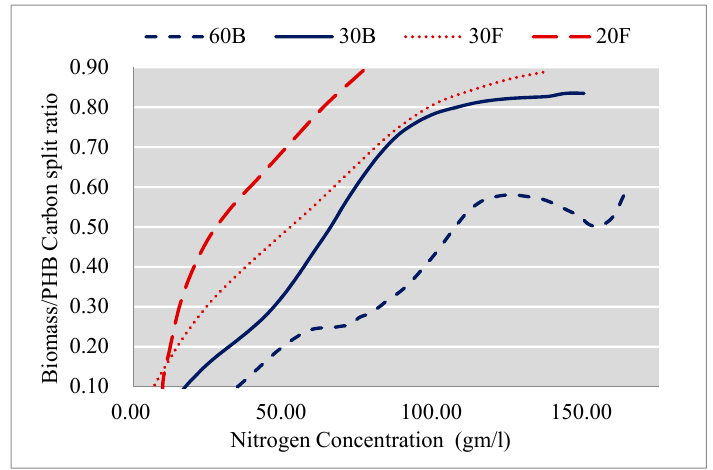
Figure 7. Plot of the flux split ratio ‘v biomass / (v biomass + v PHB )’ on a per carbon basis against the remaining concentration of nitrogen in the medium. Table 3. Duration of Phase II and growth phase, percentage of total PHB produced in Phase II, PHB productivity in Phase II and Phase